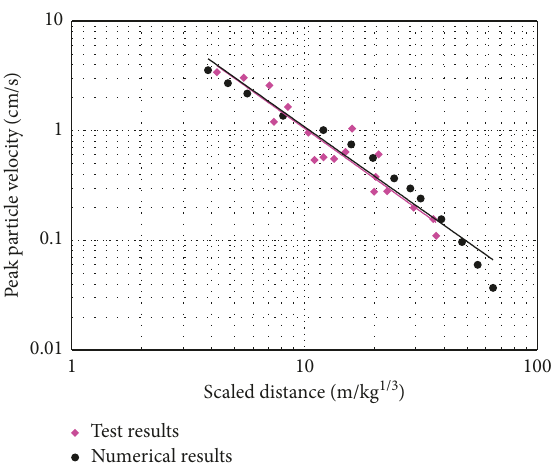
Figure 13: Attenuation of PPV between test and numerical results.